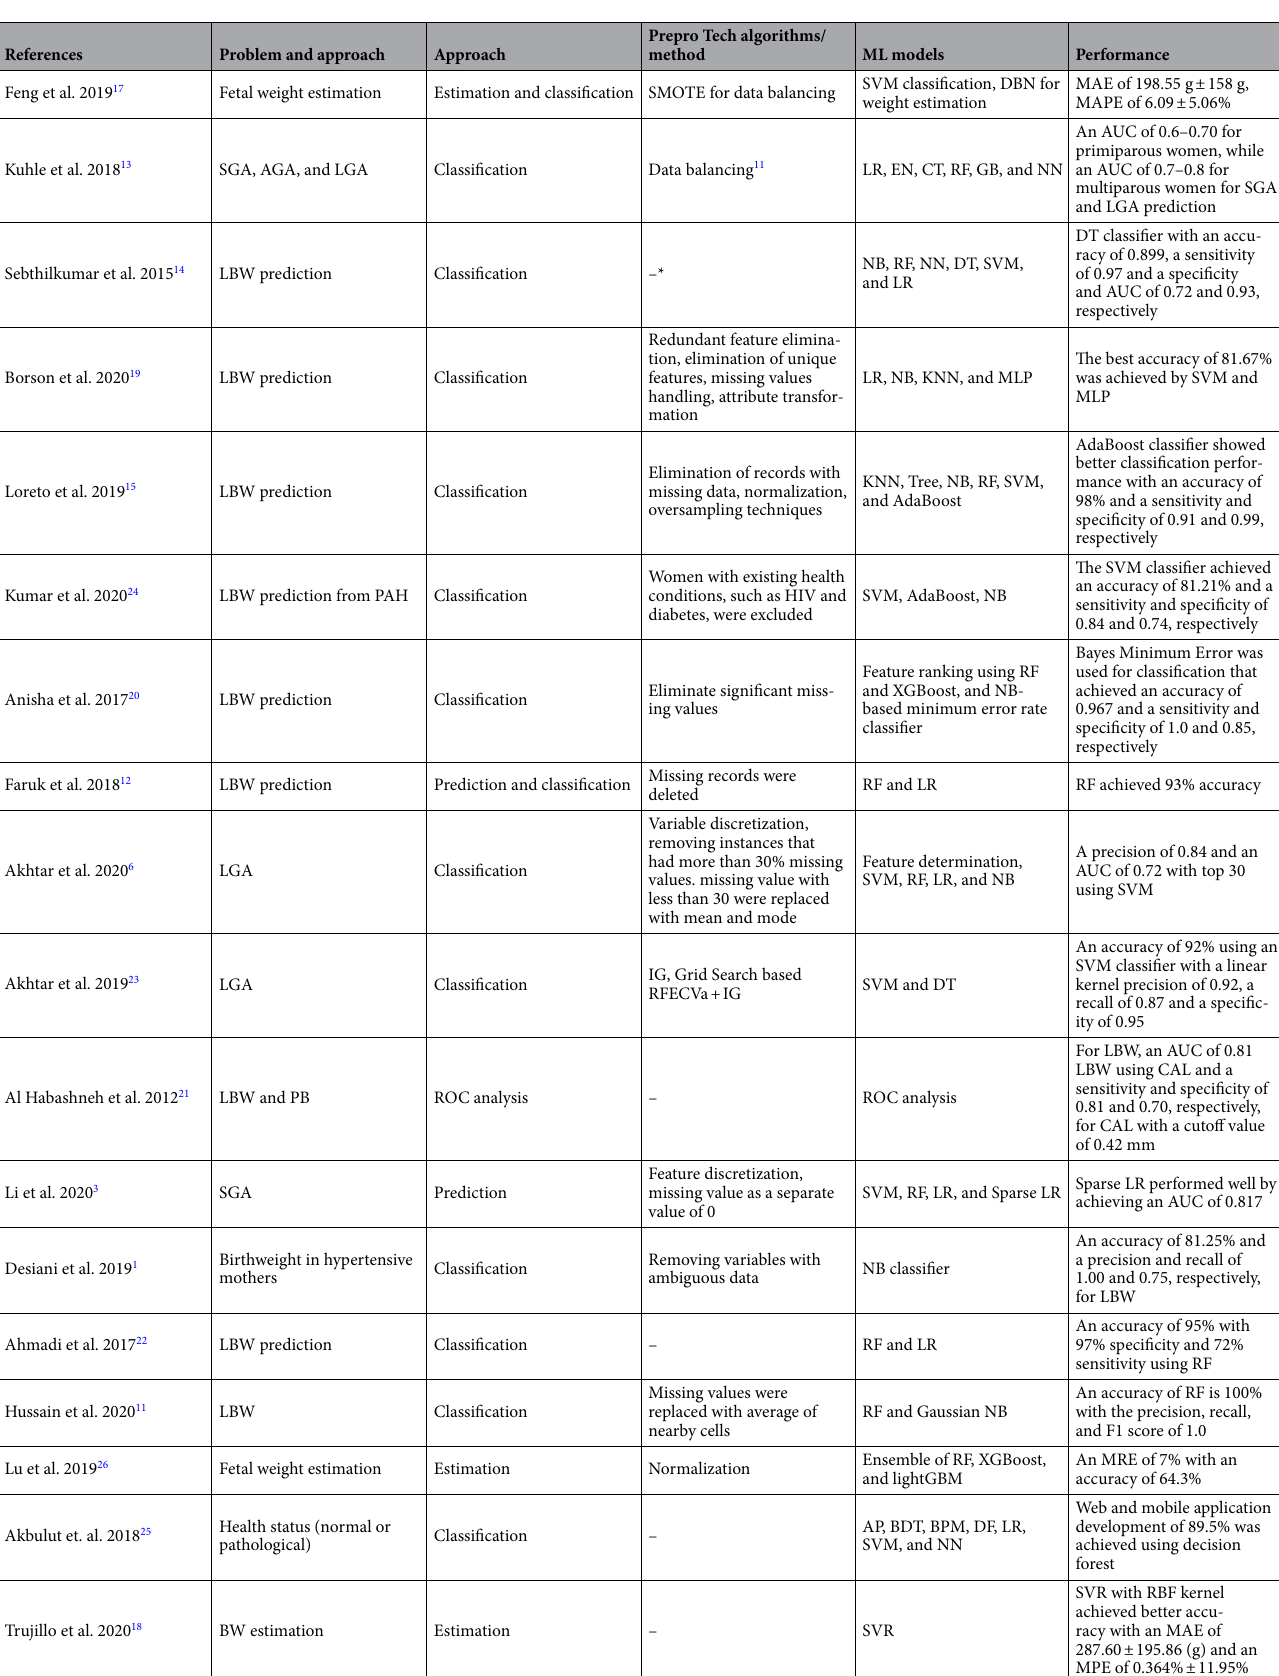
Table 1. Work related to LBW